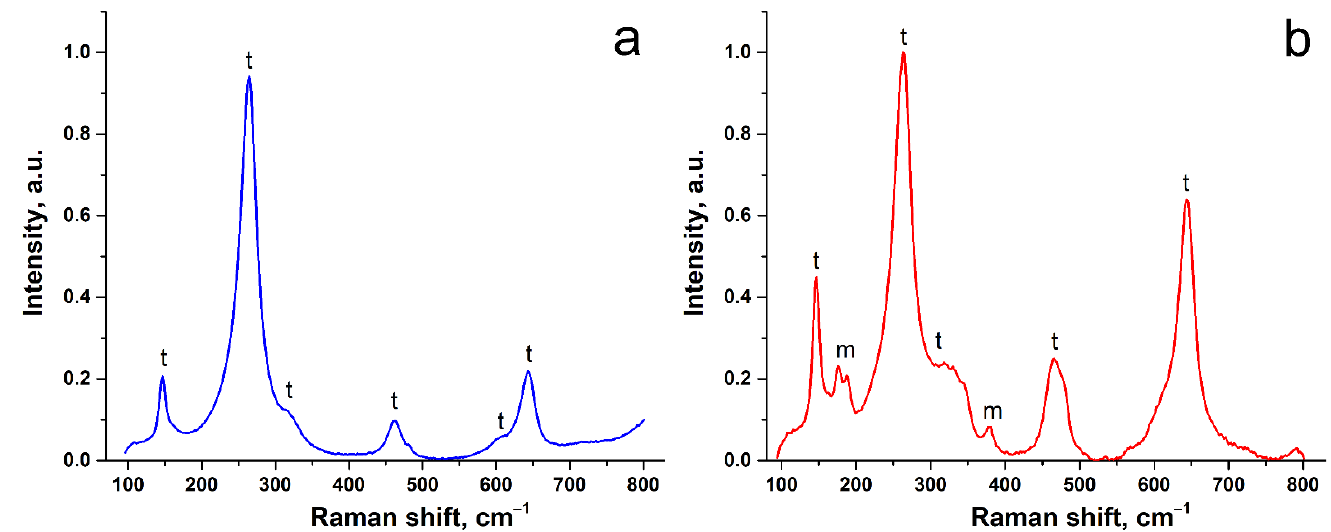
Figure 6. Raman spectra of (ZrO 2 ) 0.96 (Sm 2 O 3 ) 0.04 crystal: ( a ) near the indentation, ( b ) inside the indentation.